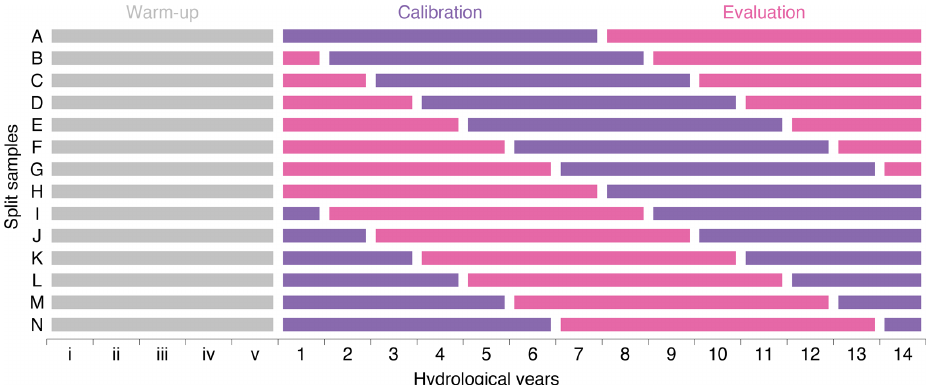
Figure 3. Split-sampling strategy using a 7-year rolling window, adapted from de Lavenne et al. (2016). Each period of 14 hydrological years enumerated as decimal numerals in Fig. A1 is represented on the x axis and split into two 7-year periods, one for model calibration (in purple), and one for model evaluation (in pink). Each period of 5 hydrological years identified as roman numerals on the x axis corresponds to the 5-consecutive-year warm-up period immediately preceding the hydrological year number 1.